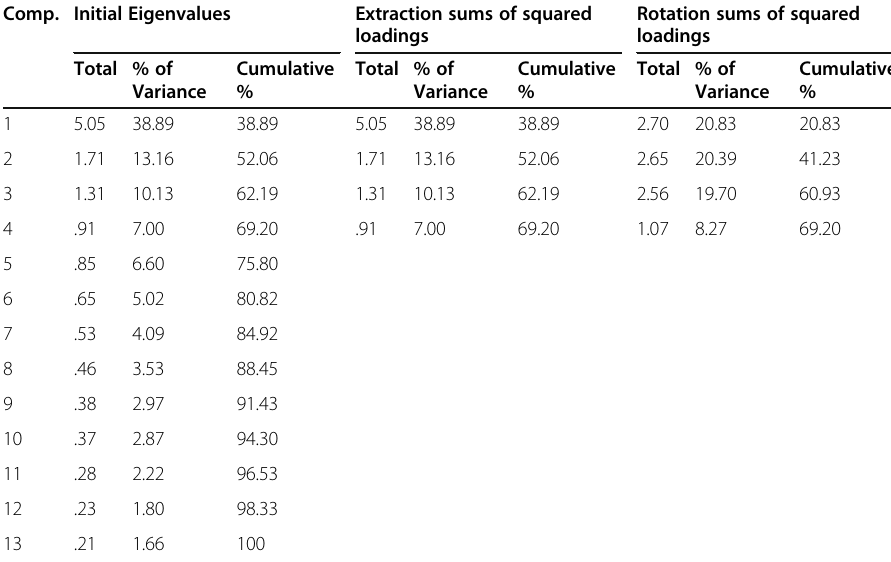
Table 9 Total variance explained (Rater 1 removed) Comp. Initial